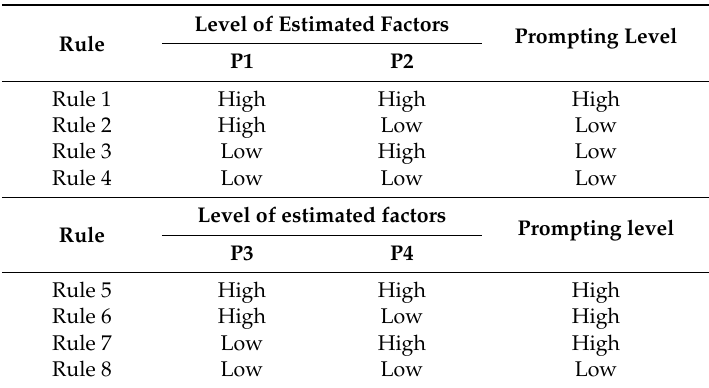
Table 3. The rules of fuzzy